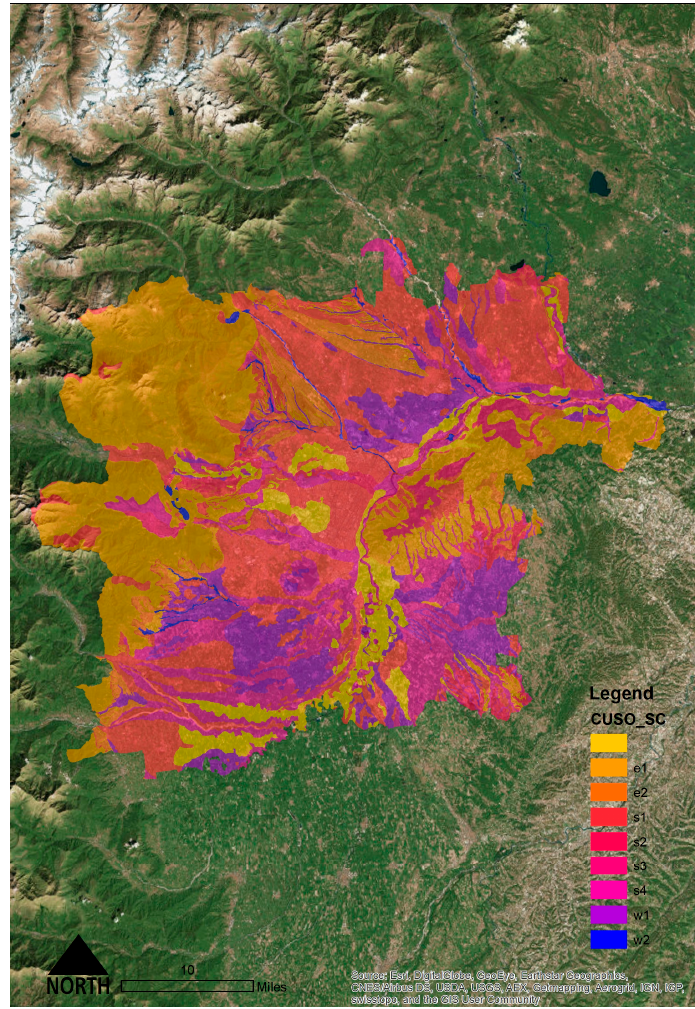
Figure 2. Land capability classification map used in the study area. Each class is associated to a specific soil characterization. Table 2. Table of input data associated to the Land capability classification